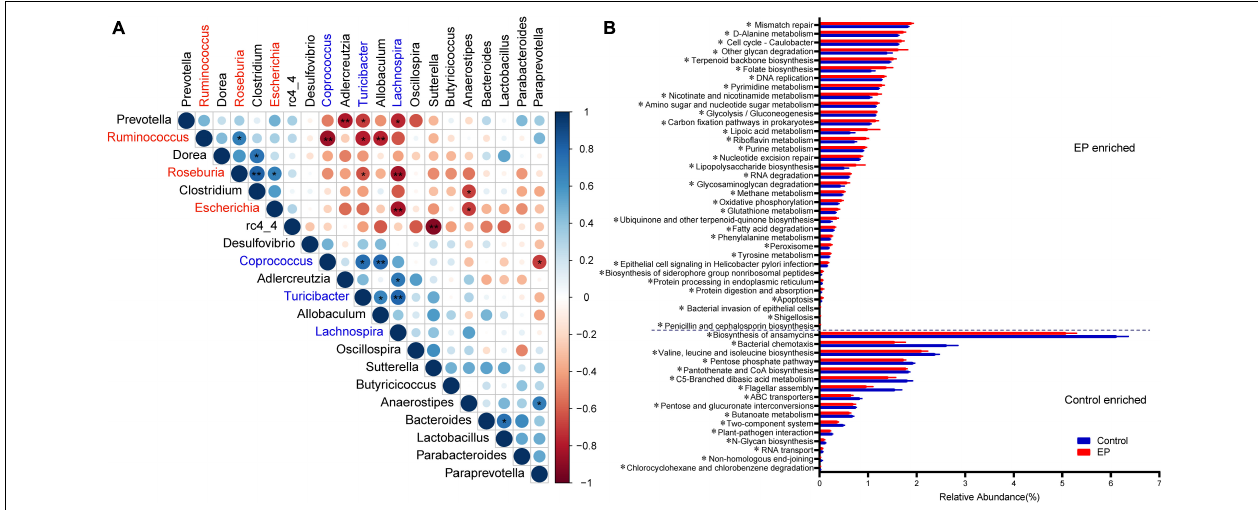
FIGURE 3 | Relationships and predicted functions of gut microbiota. (A) Spearman’s rank correlation matrix of bacterial genera with > 0.2% abundance in at least one sample. Circle size increases with absolute correlation and circle color denotes the nature of the correlation. On the scale, 1 indicates a complete positive correlation (dark blue) and − 1 indicates a complete negative correlation (dark red) between the two microbial genera. Significant correlation between genera (* p < 0.05 and ** p < 0.01). (B) Differentially enriched KEGG functions pathways (level 3) between EP and Control by PICRUST2 analysis. EP, experimental periodontitis group; Control, healthy control group.